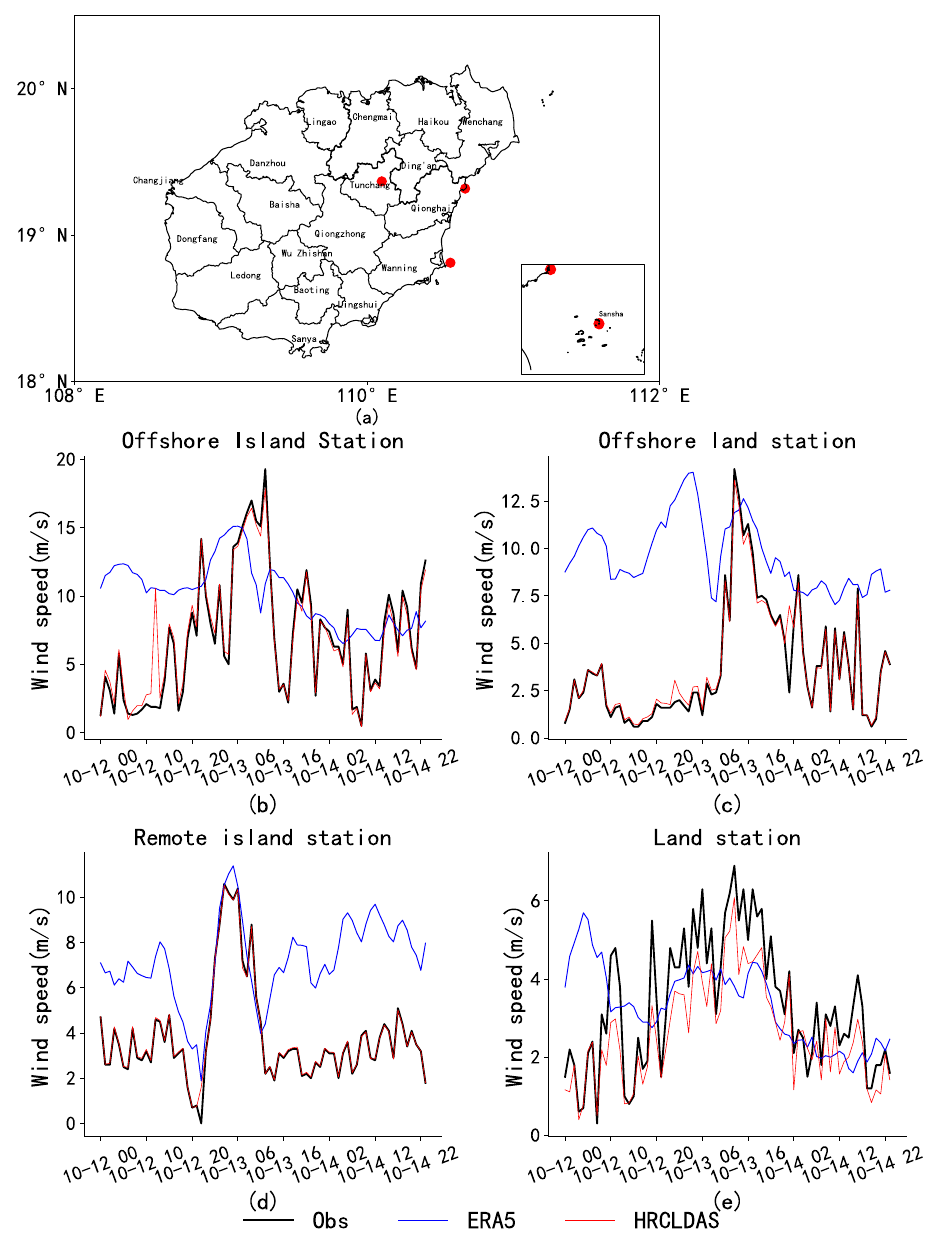
Figure 12. ( a ) Location map of example stations. Time series of near-surface wind speed on 12–14 October 2020: ( b ) offshore island station (Wanning Bai’an Island Station); ( c ) offshore land station (Qionghai Qingge Port Station); ( d ) remote Island Station (Xisha Station); and ( e ) land Station (Tunchang Station).